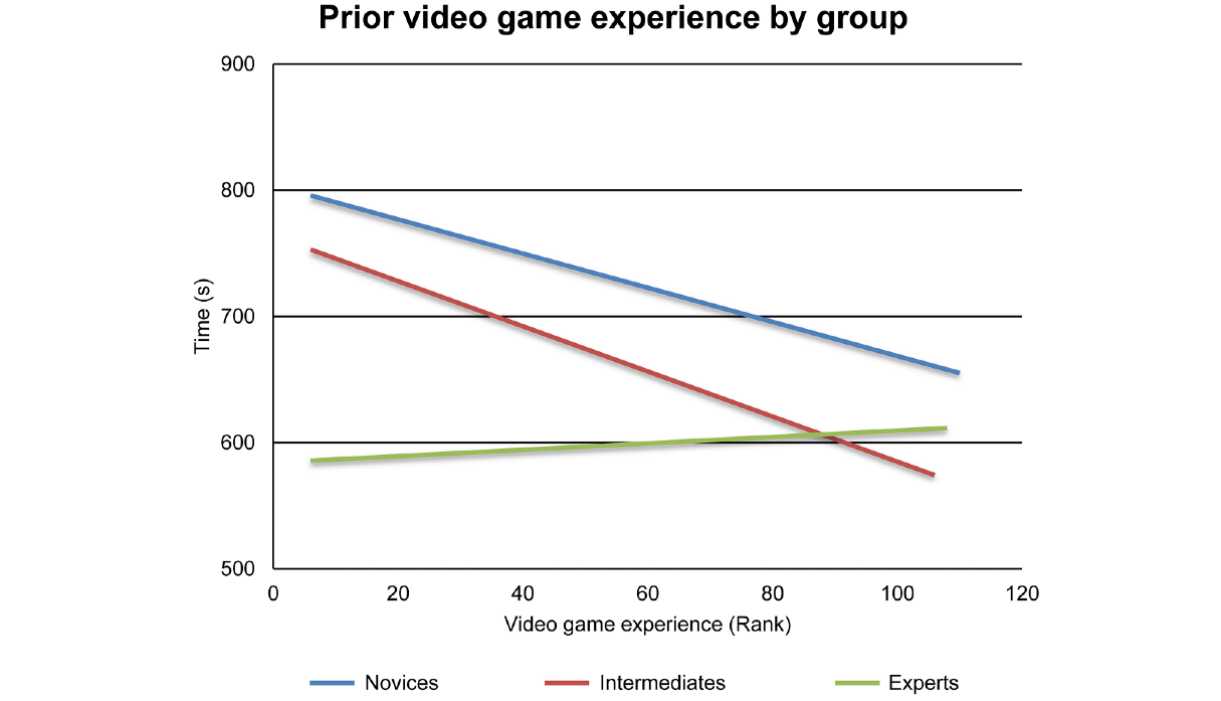
Figure 3. Linear trend lines showing the correlation between video game experience and the performance variable of time for each group.